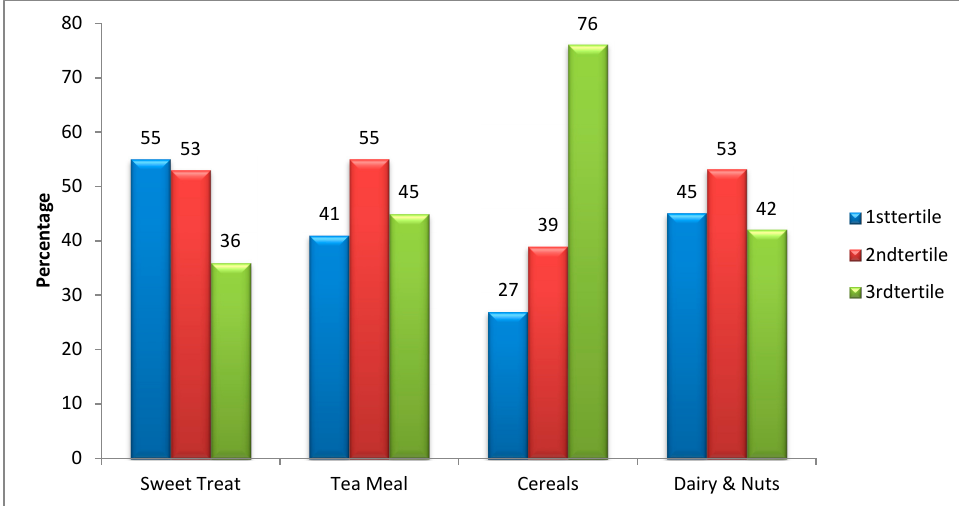
Figure 1. Association between DMFT and four dietary patterns (sweet treat, tea meal, cereals, dairy and nuts).